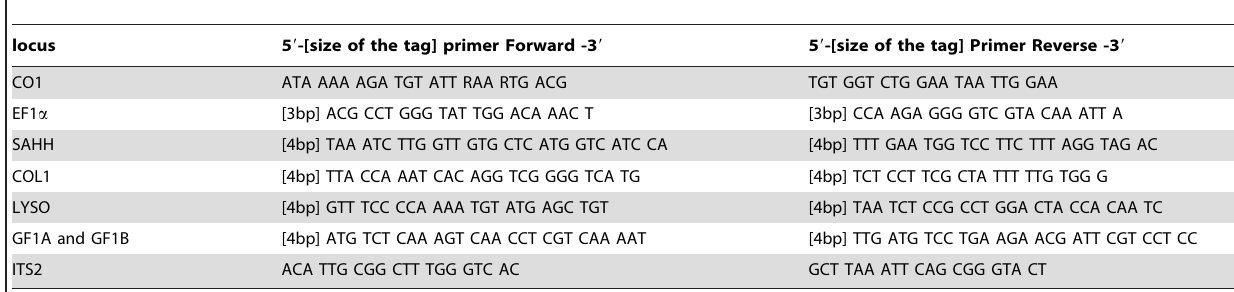
Table 1. Sequences of PCR